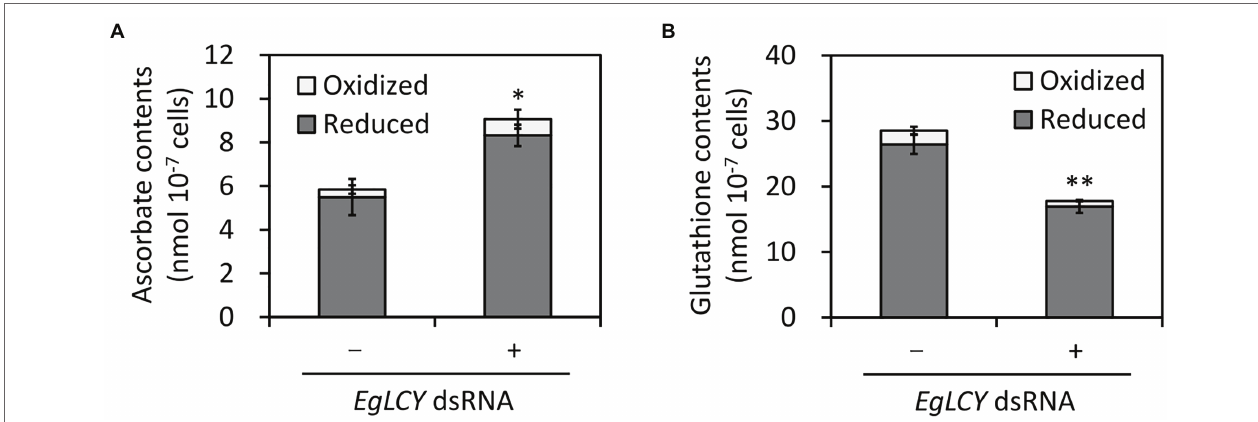
FIGURE 7 | Effects of EgLCY suppression on antioxidant contents. Cells treated with or without EgLCY dsRNA were mixotrophically grown under continuous light (40 μ mol photons m − 2 s − 1 ) at 25 ° C for 6 d. The contents of ascorbate (A) and glutathione (B) in extracts from cells treated with or without EgLCY dsRNA. Values are presented as the mean ± SD ( n = 3). Values with asterisks are significantly different from cells treated without dsRNA according to the t -test (* p < 0.05; ** p < 0.01). Statistical analysis was performed on the total contents of each